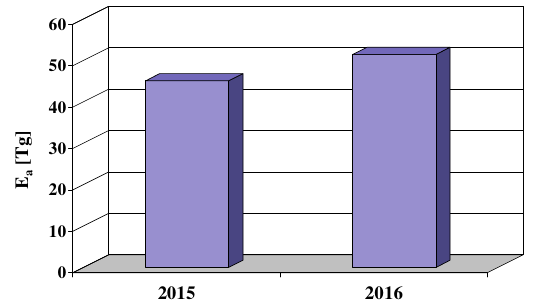
Fig. 11. National annual emission of black carbon from motor vehicles in 2015 and 2016